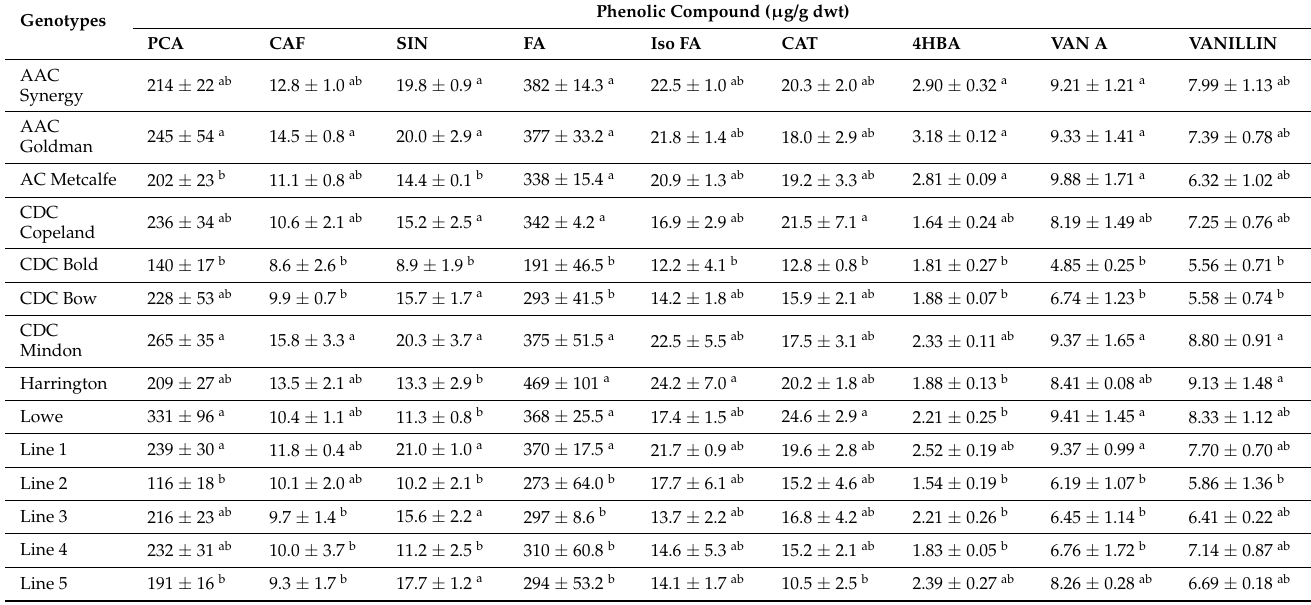
Table 4. Bound phenolic compound content ( µ g/g dwt) in barley grain